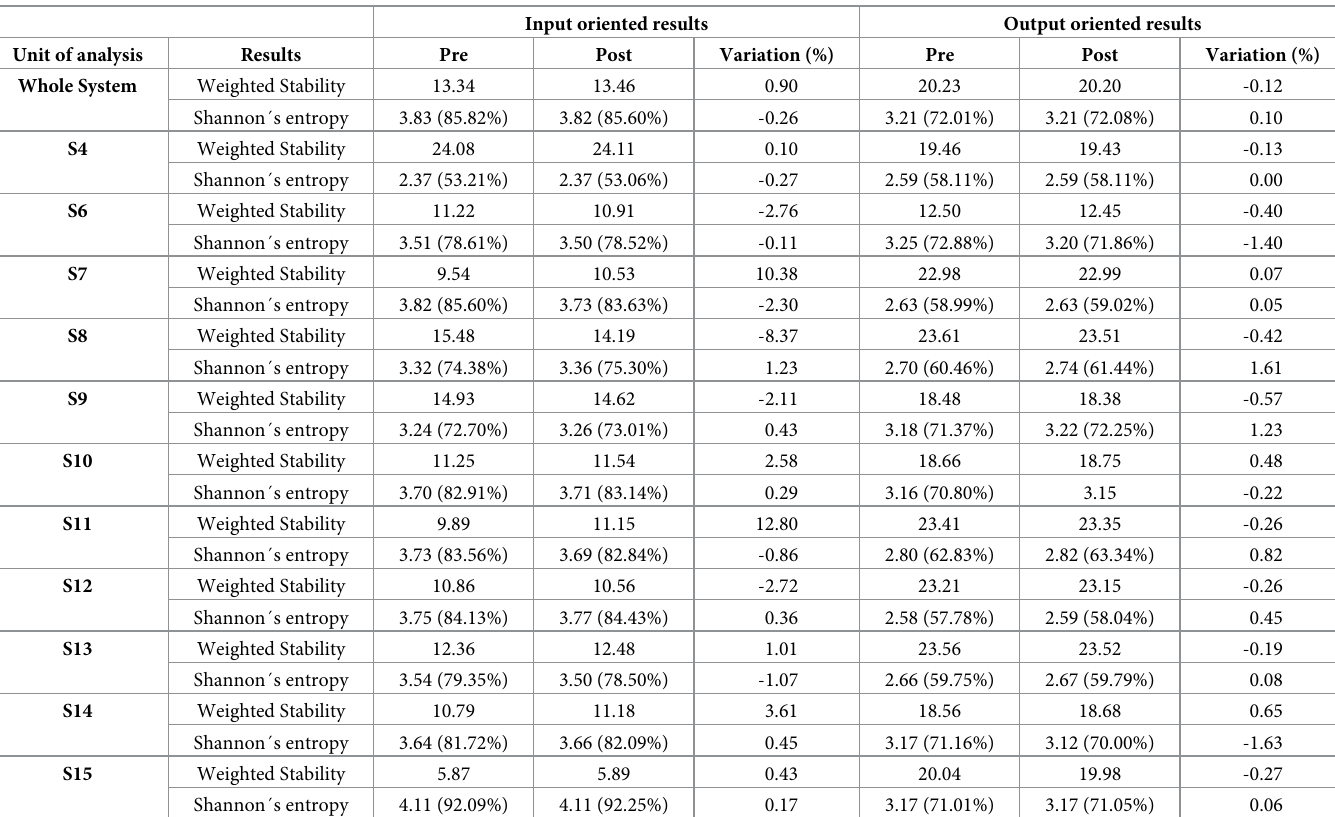
Table 5. Scenario stability and entropy (in brackets the entropy in percentage up to its